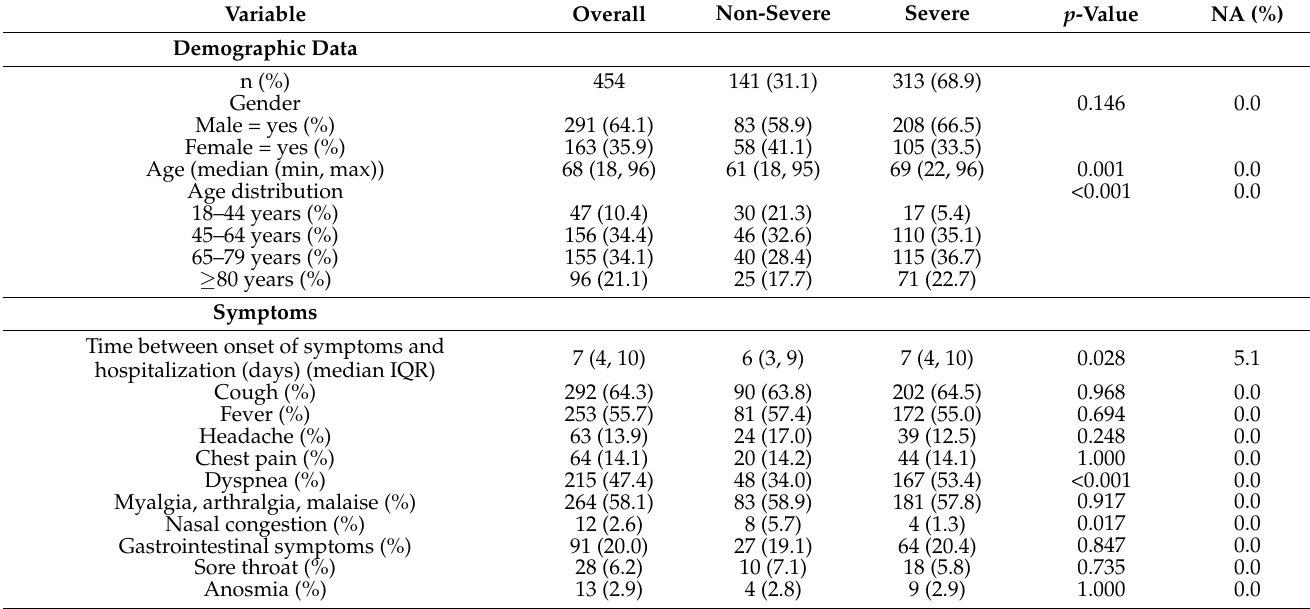
Table 1. Clinical characteristics of patients hospitalized due to COVID-19 (n =